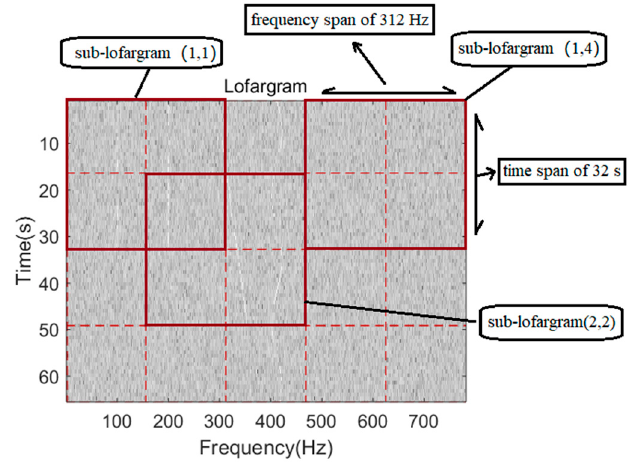
Figure 11. Segmentation.